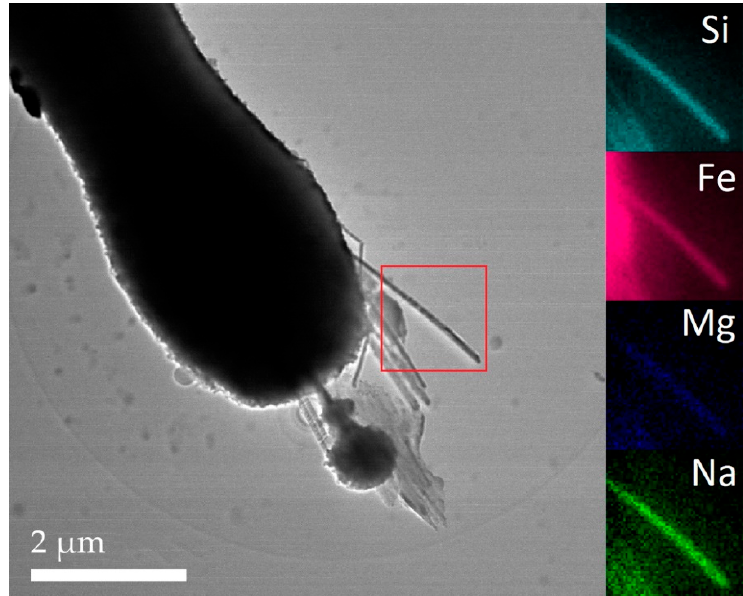
Figure 6. STEM image of crocidolite fibres. The red square identifies the area selected to carry out the EDX mapping. The fibre inside the red square is the same as in Figure 5. The STEM-EDX maps on the right side show the spatial distribution of Si (turquoise), Fe (red), Mg (violet), and Na (green). The maps were generated after background subtraction performed on the spectra obtained in the studied region of interest (ROI).